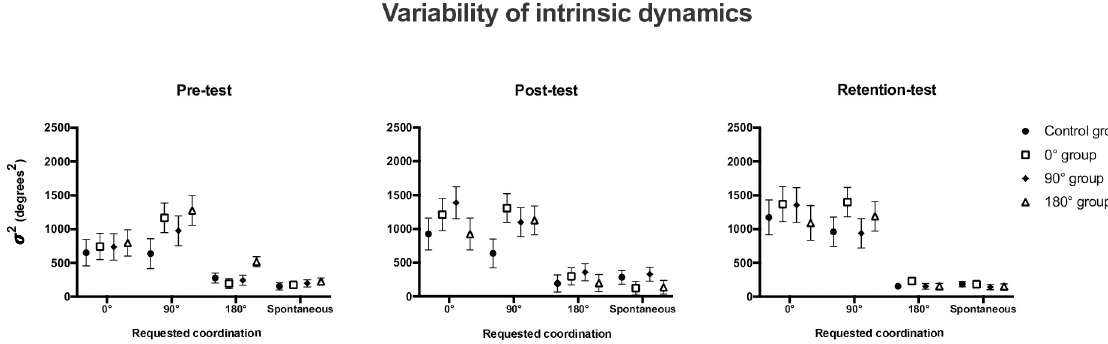
Fig 4. Depictions of the variability of coordination intrinsic dynamics: Variability ( σ 2 , in degrees 2 ) of trunk/horse coordination (mean ± standard error) for each group at each requested coordination patterns during pre- (left panel), post- (middle panel) and retention tests (right